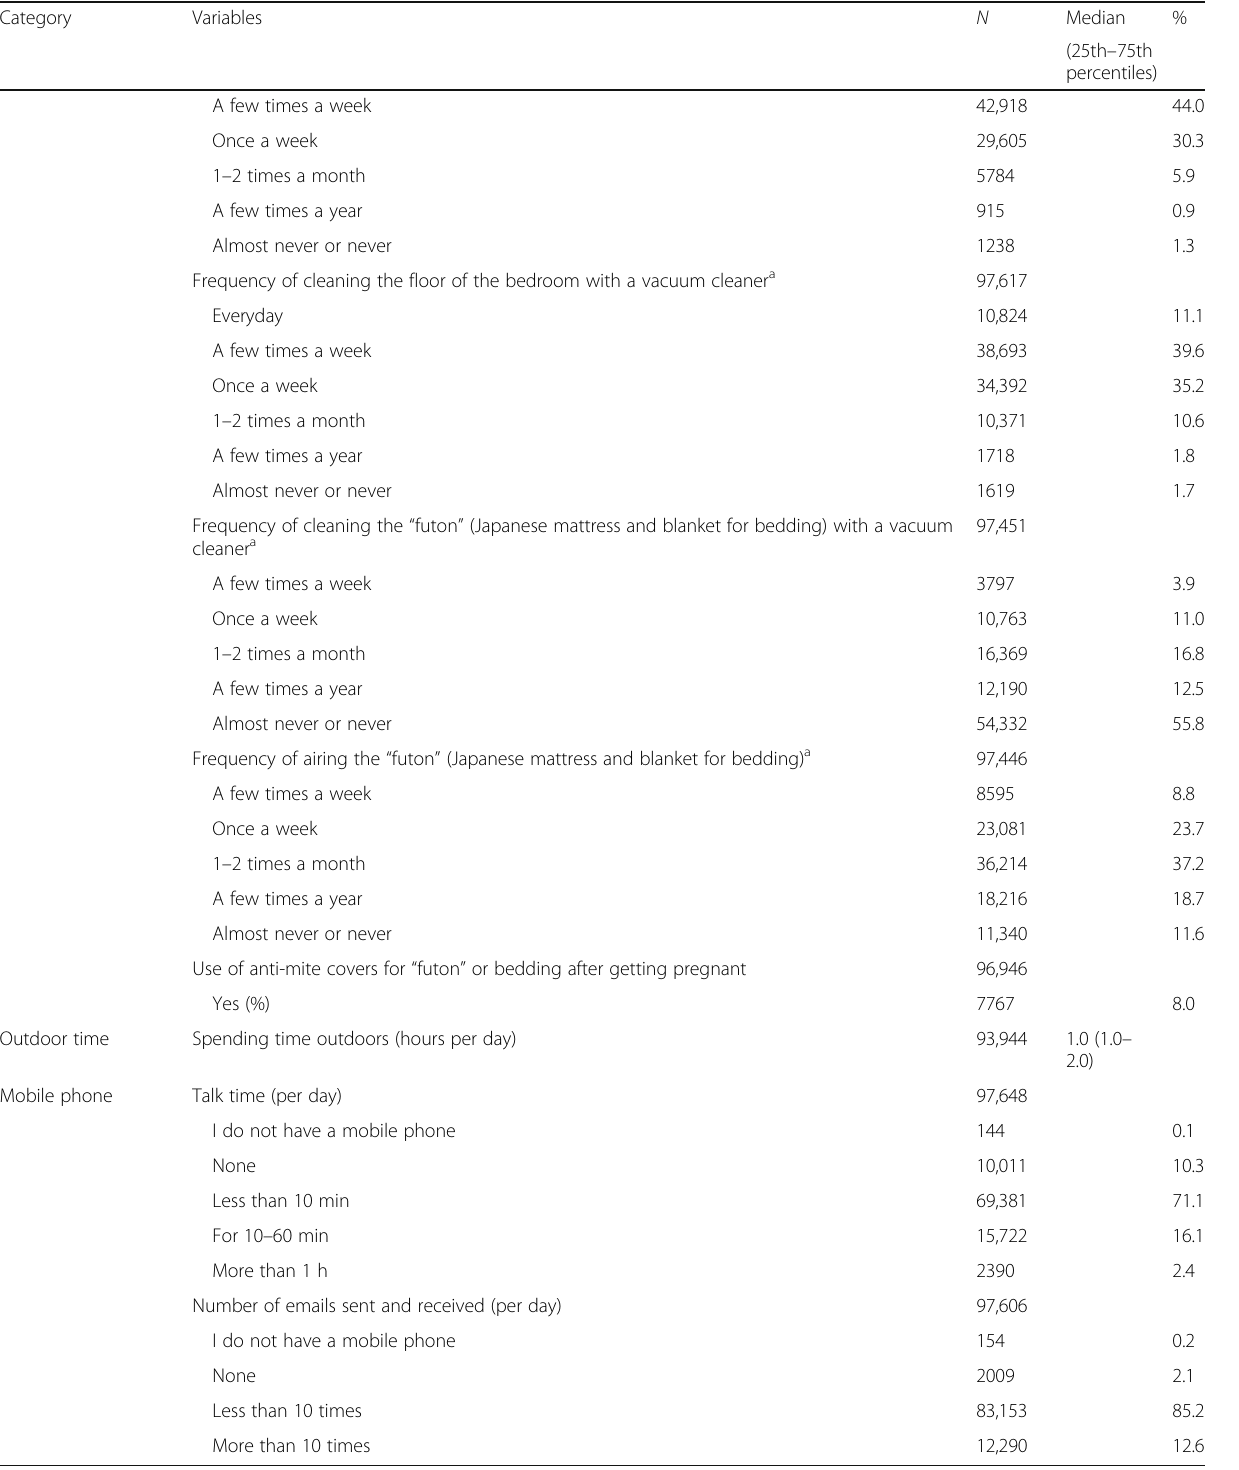
Table 5 Household environment characteristics during pregnancy (MT2) (Continued)